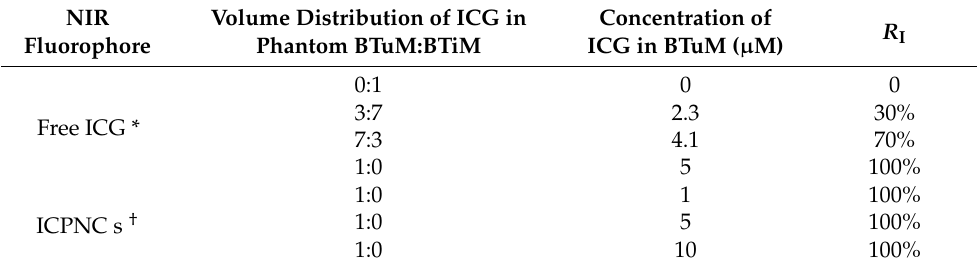
Table 1. Experimental setting for the FDOT detection in vitro.